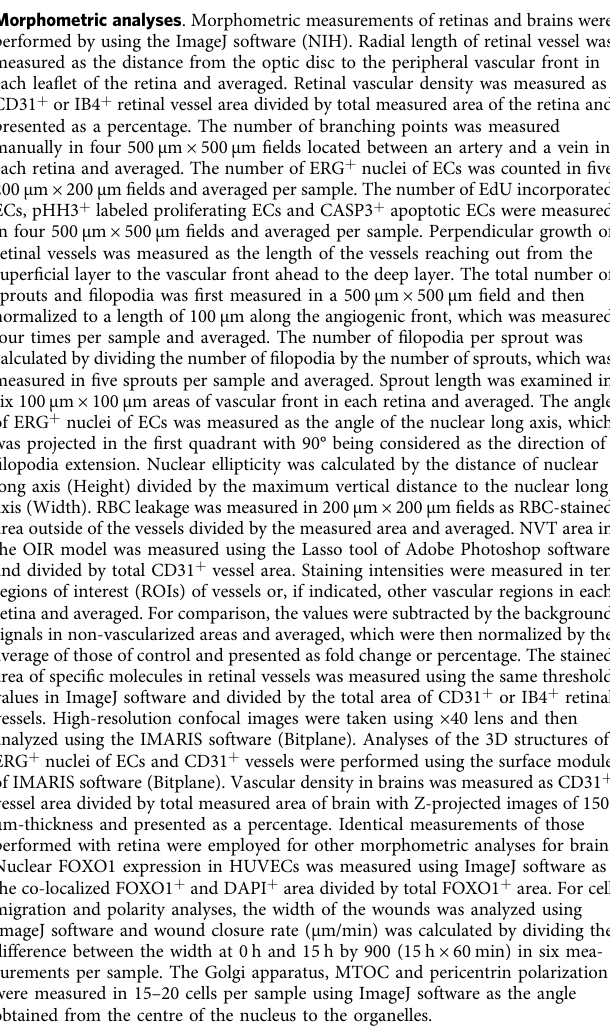
numbers indicate the frequency of dots within the 120° region of the bold line. Source data are provided as a Source Data